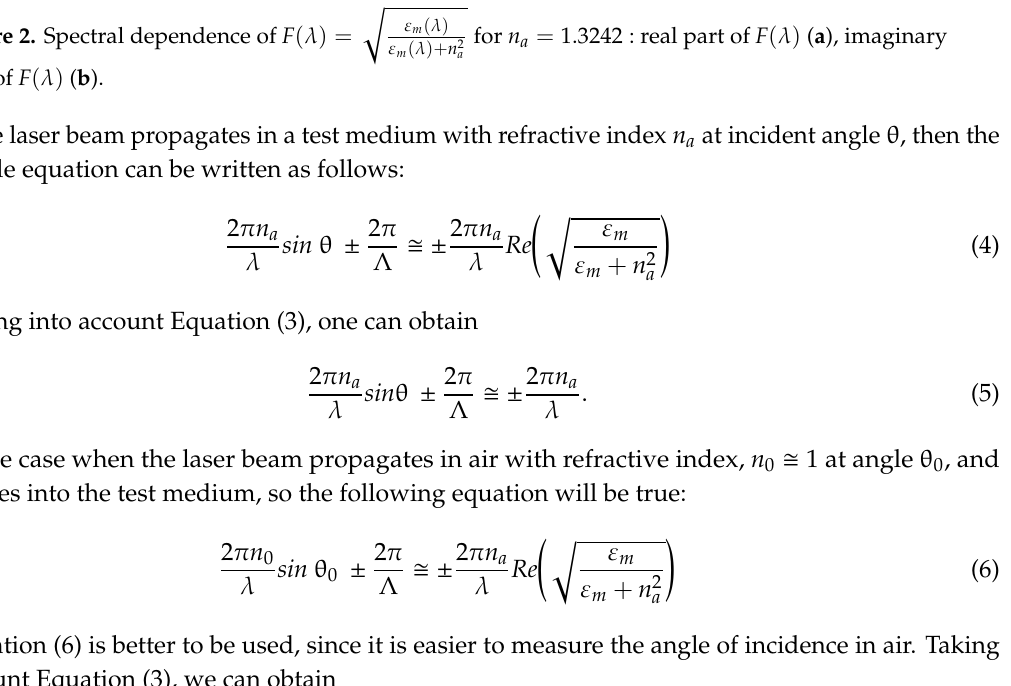
(cid:114) ((cid:3090)) ε λ ) for 𝑛 (cid:3028) = 1.3242: real part of 𝐹(𝜆) ( a ), imaginary m ( for n a = 1.3242 : real part of F ( λ ) ( a ), imaginary (cid:3084) (cid:3288) ((cid:3090))(cid:2878)(cid:3041) (cid:3276)(cid:3118) ε λ )+ n 2 m ( a